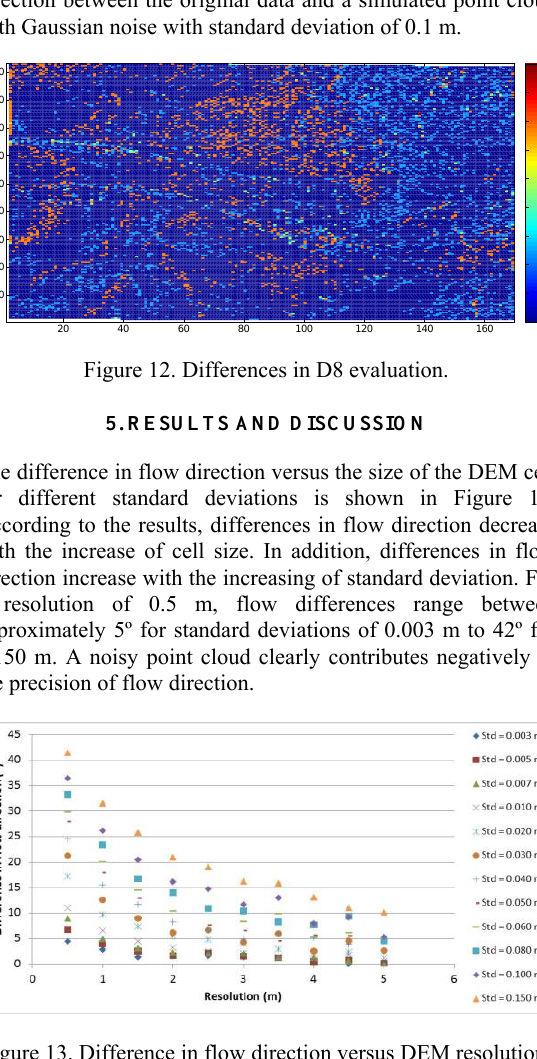
Figure 13. Difference in flow direction versus DEM resolution.